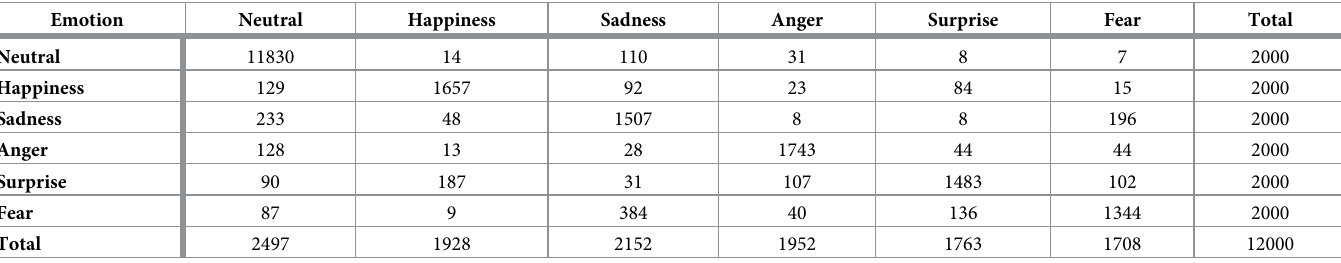
Table 8. Confusion matrix for Phase 2 evaluation result.